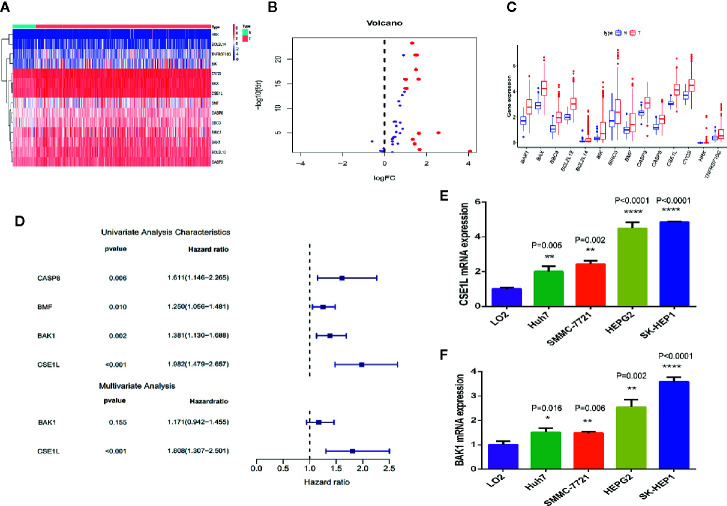
Differential expression analysis and identification of key apoptosis genes related to prognosis in HCC. (A) The heat map showed the expression levels of 14 apoptotic genes in HCC tissues and noncancerous tissues. (B) The histogram indicated the expression patterns of 14 apoptotic genes in HCC tissues and noncancerous tissues. (C) The volcano plot indicates that the 14 differentially expressed genes satisfy the condition of P < 0.05 and log FC > 1. (D) Univariate and multivariate Cox regression analysis performed to identify the genes closely associated with the prognosis of HCC patients. (E, F) qRCR was used to measure the mRNA level of CSE1L (E) and BAK1 (F) in human L02 hepatocytes and HCC cell lines. *P < 0.05; **P < 0.01; ****P < 0.0001.